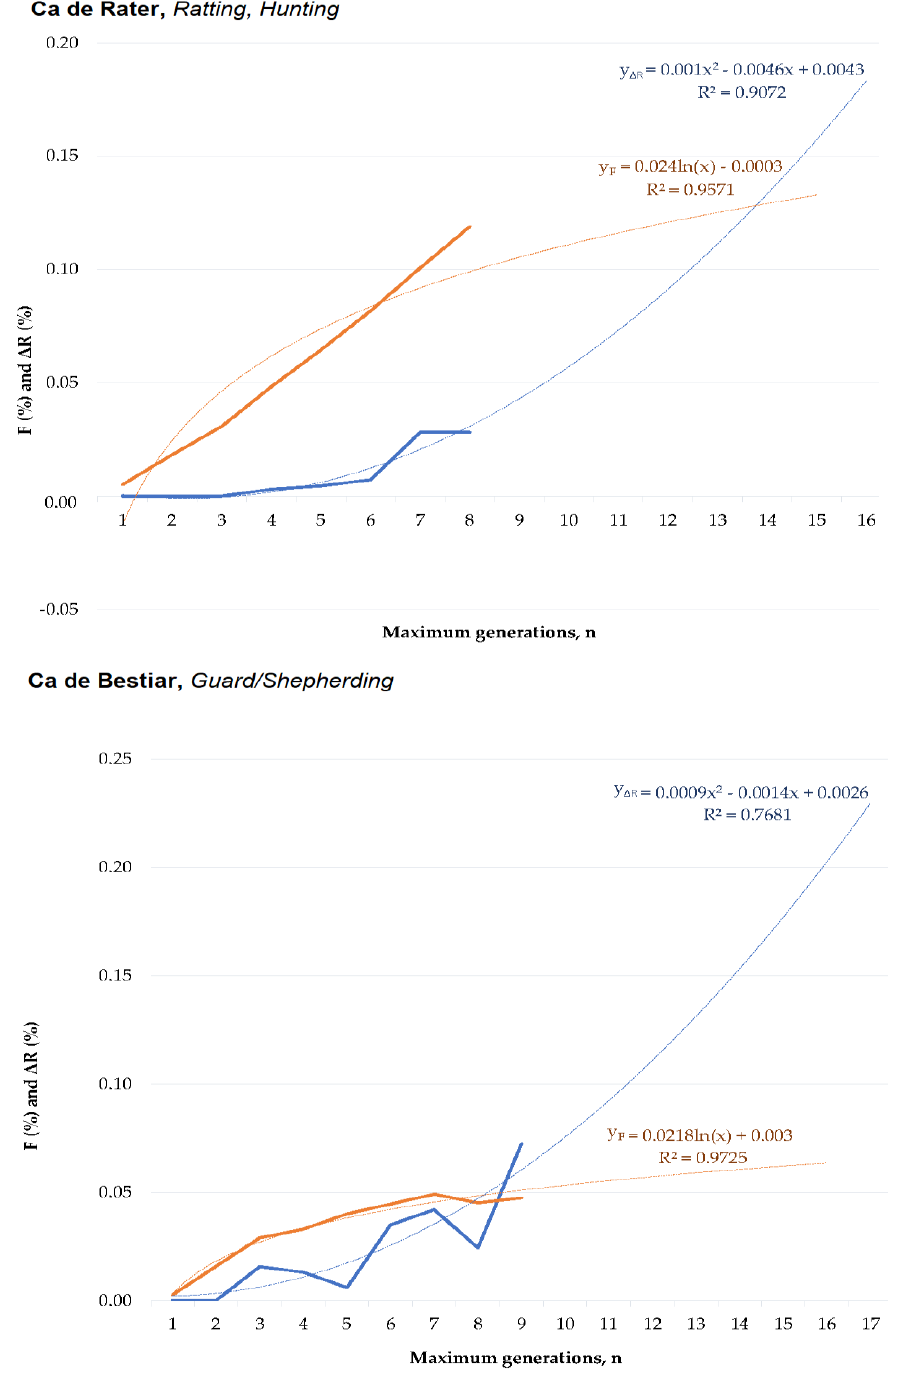
Figure 1. Logarithmic and quadratic regression equations for mean inbreeding (F) and relatedness coefficients (ΔR) from the first to fifth generation and predicted inbreeding (F) and relatedness coefficients (ΔR) from the sixth to 15th generation in the Ca de Rater (CR) and Ca de Bestiar (CB) dog breeds.